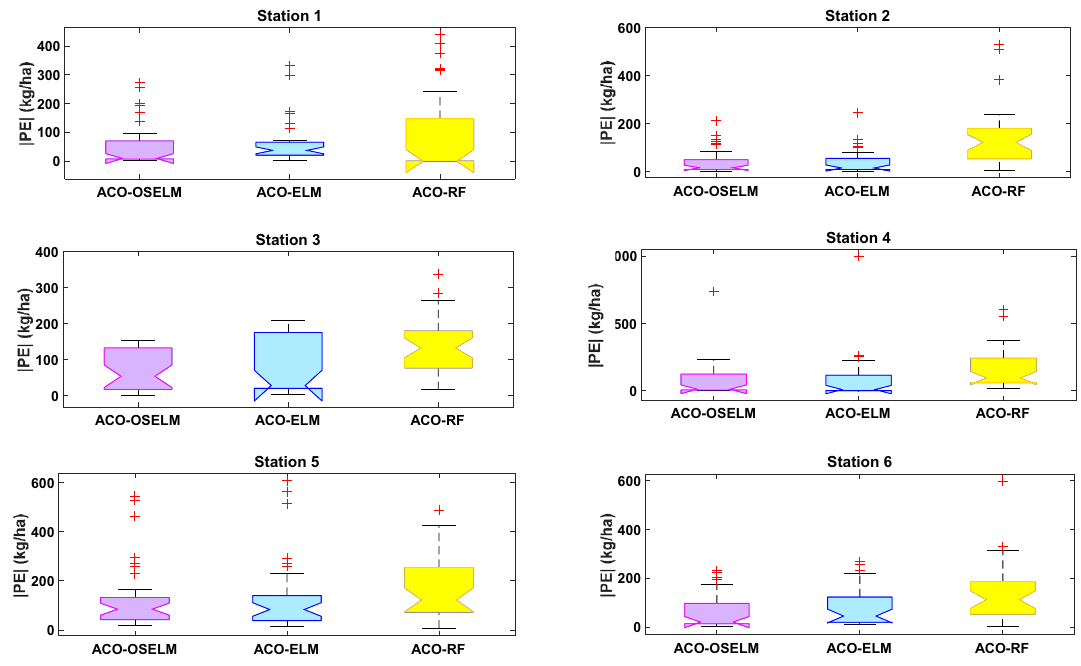
Figure 8. Boxplots of the prediction error |PE| (kg ha −1 ) of ACO-OSELM versus ACO-ELM and ACO-RF models between the predicted and observed wheat yield for Station 1: Rahimyar Khan, Station 2: D. G. Khan, Station 3: Kasur, Station 4: Sialkot, Station 5: Rawalpindi, and Station 6: Jhang.